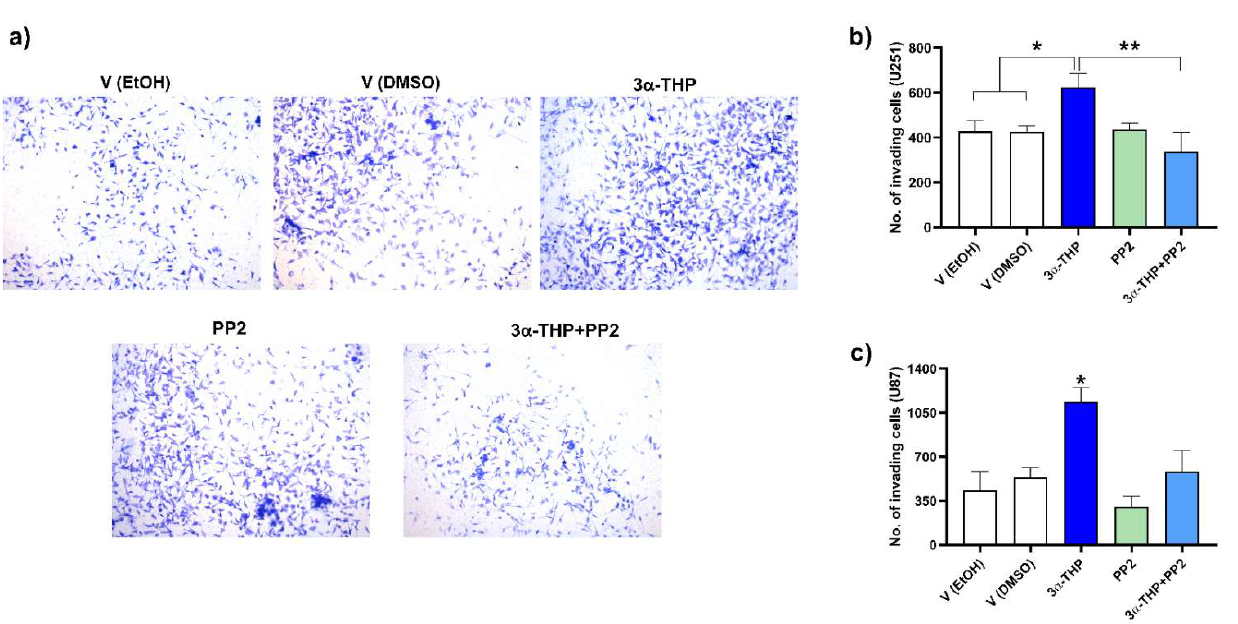
Figure 7. Effect of 3α-THP and the pharmacological inhibitor of c-SRC PP2 on U251 and U87 cell invasion. ( a ) Representative images of U251 cell invasion assays. All photographs were taken at 10× augment. ( b ) Graph of the number of invading U251 cells per field. Each column represents the mean ± SEM., n = 4; * p < 0.05 3α-THP vs. V (EtOH, and DMSO); ** p < 0.005 3α-THP vs. 3α-THP + PP2. ( c ) Graph of the number of invading U87 cells per field. Each column represents the mean ± SEM., n = 4; * p < 0.05 3α-THP vs. all other treatments.